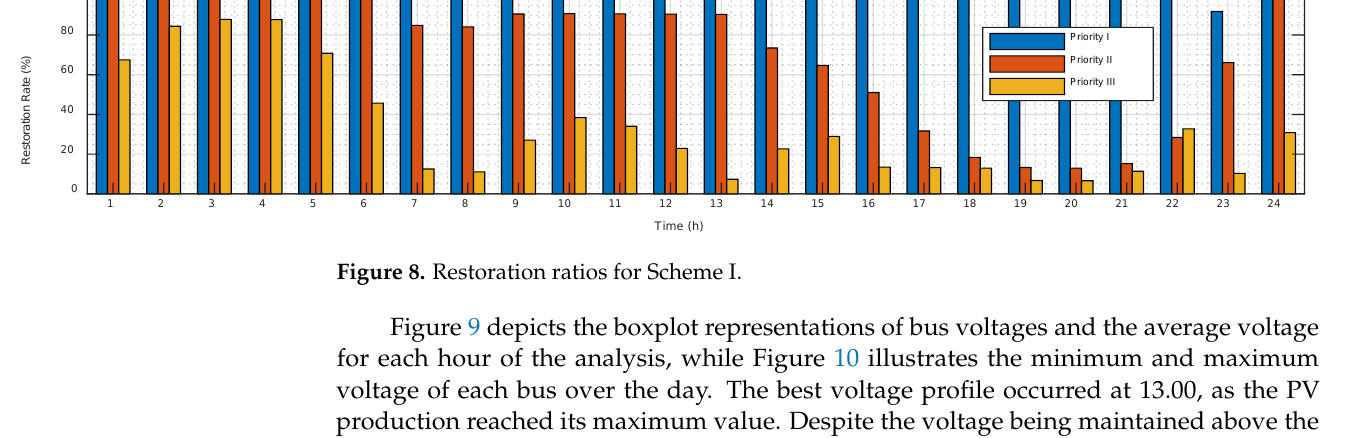
Figure 9. Boxplot representation of hourly voltage profiles for Scheme I.